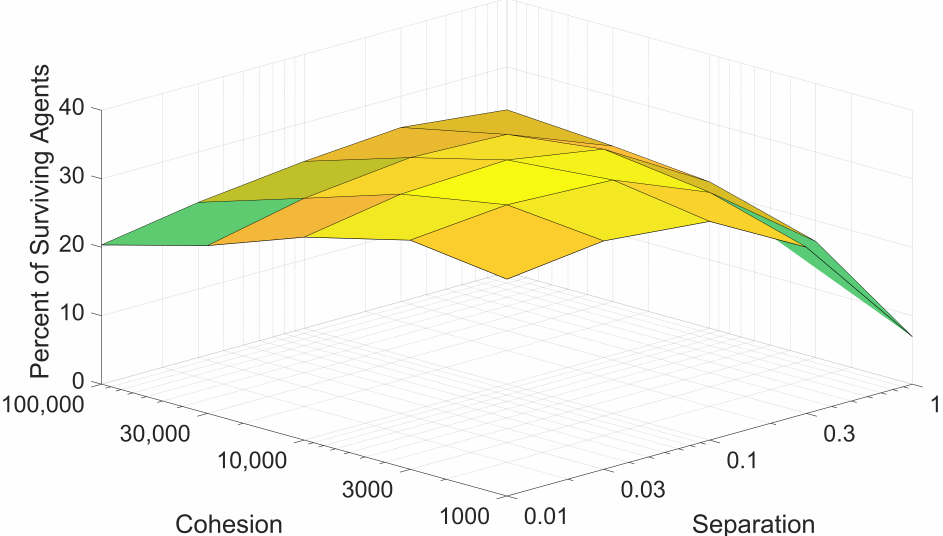
Figure 15. Mean swarm survival plotted against cohesion and separation values. Cohesion and separation values are plotted on logarithmic